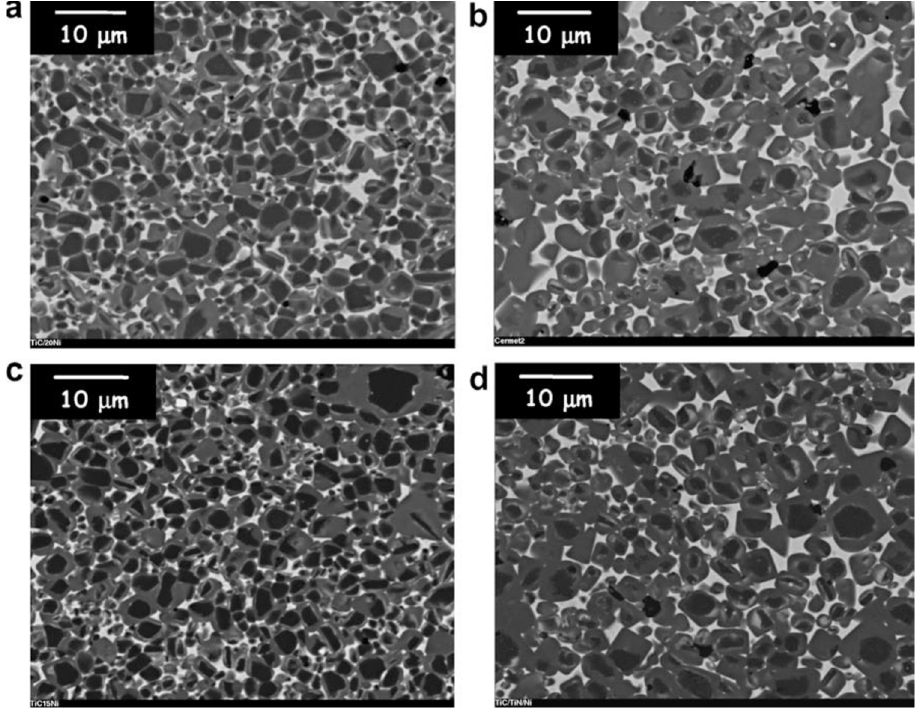
Figure 6. SEM image of cermet surface, ( a ) 0% TiN, 20% Ni, ( b ) 10% TiN, 20% Ni, ( c ) 0% TiN, 15% Ni, ( d ) 10% TiN, 15% Ni. Reprinted with permission from [48]. Copyright 2009 Elsevier.. ( d ) 10% TiN, 15% Ni. Reprinted with permission from [48]. Copyright 2009